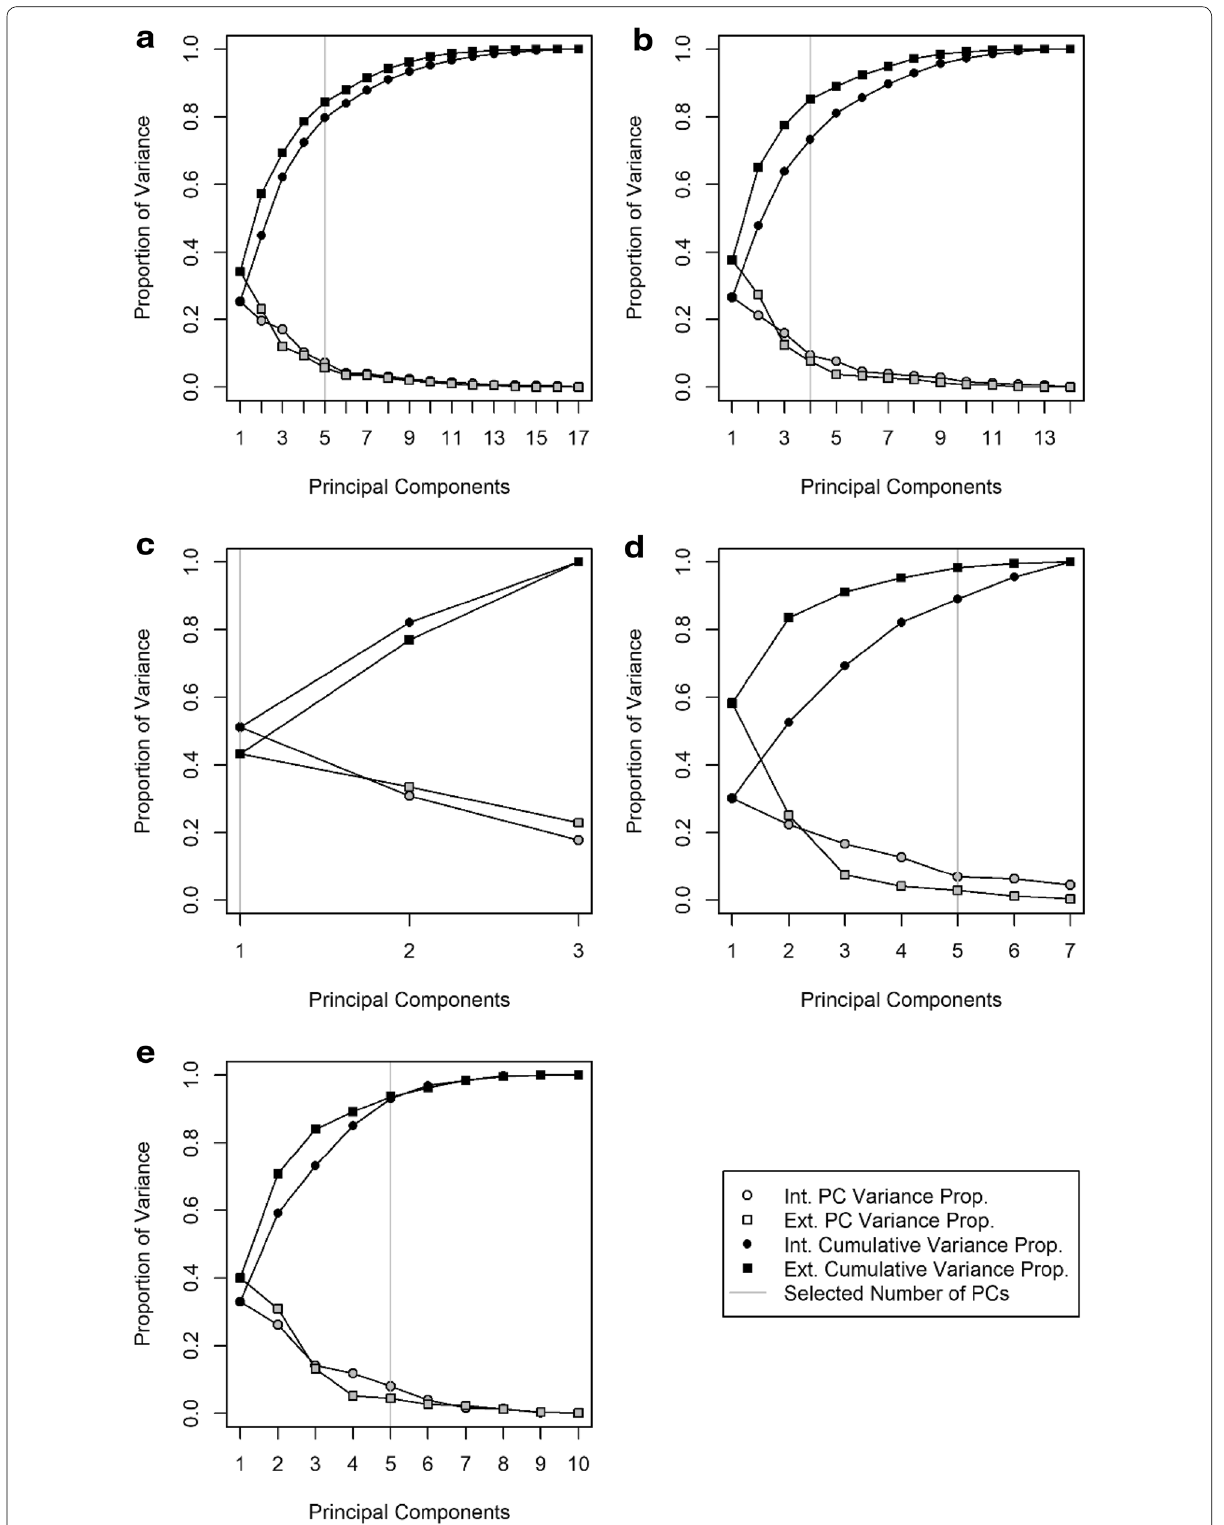
Fig. 1 Individual and cumulative explained proportion of variation for each Principal Component for a all variables and the b Continuous, c Categorical, d Self-Selected, and e Correlation Cutoff variable